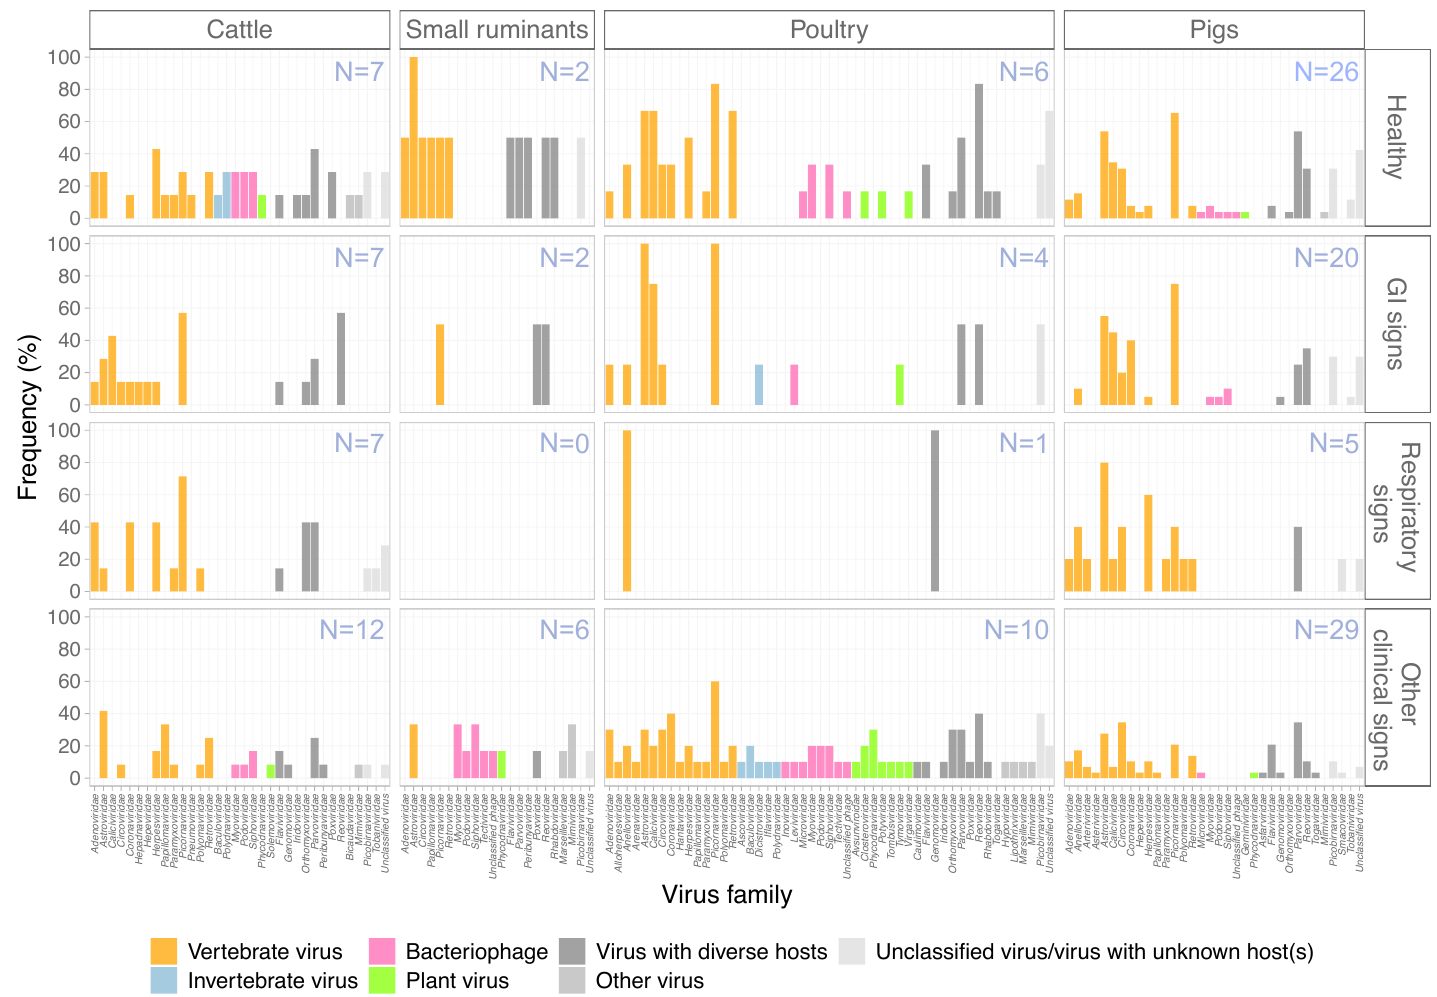
Figure 5. An overview of virus families found in di ff erent farm animals in included studies, stratified by reported health conditions. The bars are color-coded by host range of the viruses as shown in the figure legend. GI = gastrointestinal. Y axis shows proportion of studies that found the viruses